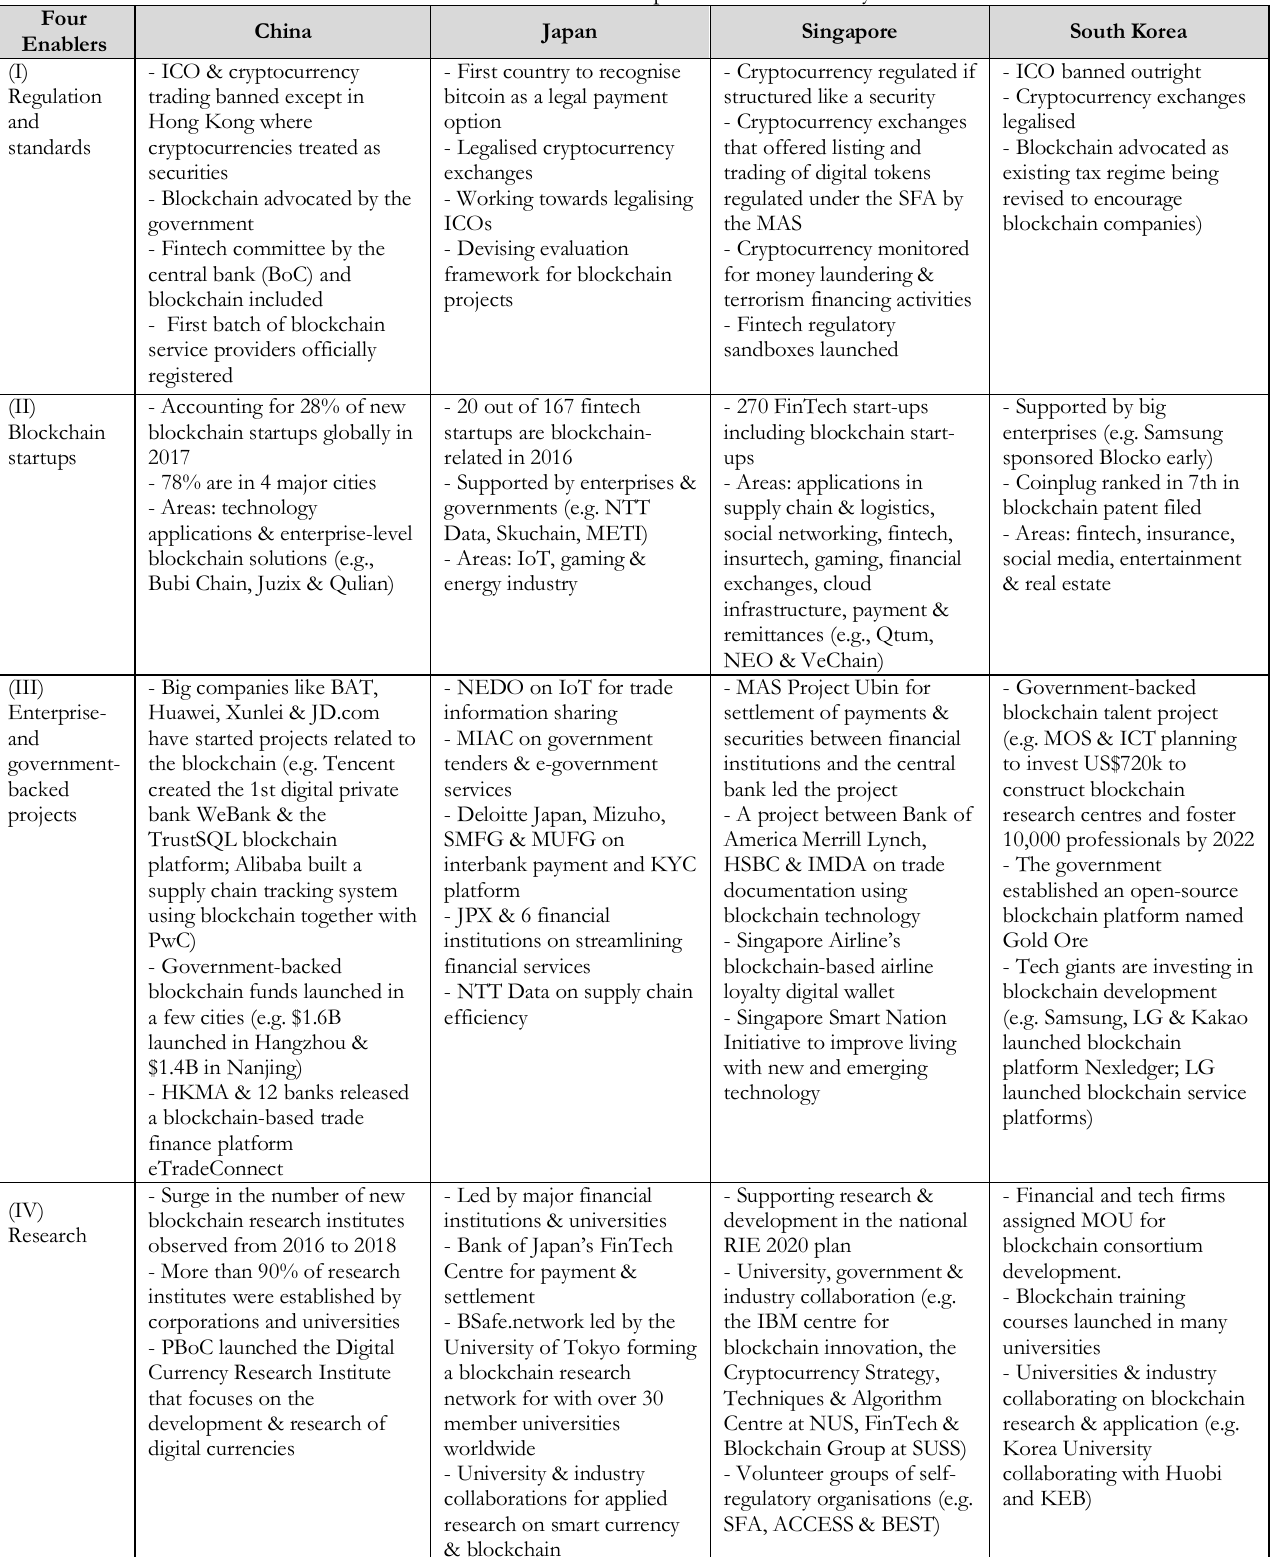
Table 1. Blockchain development status